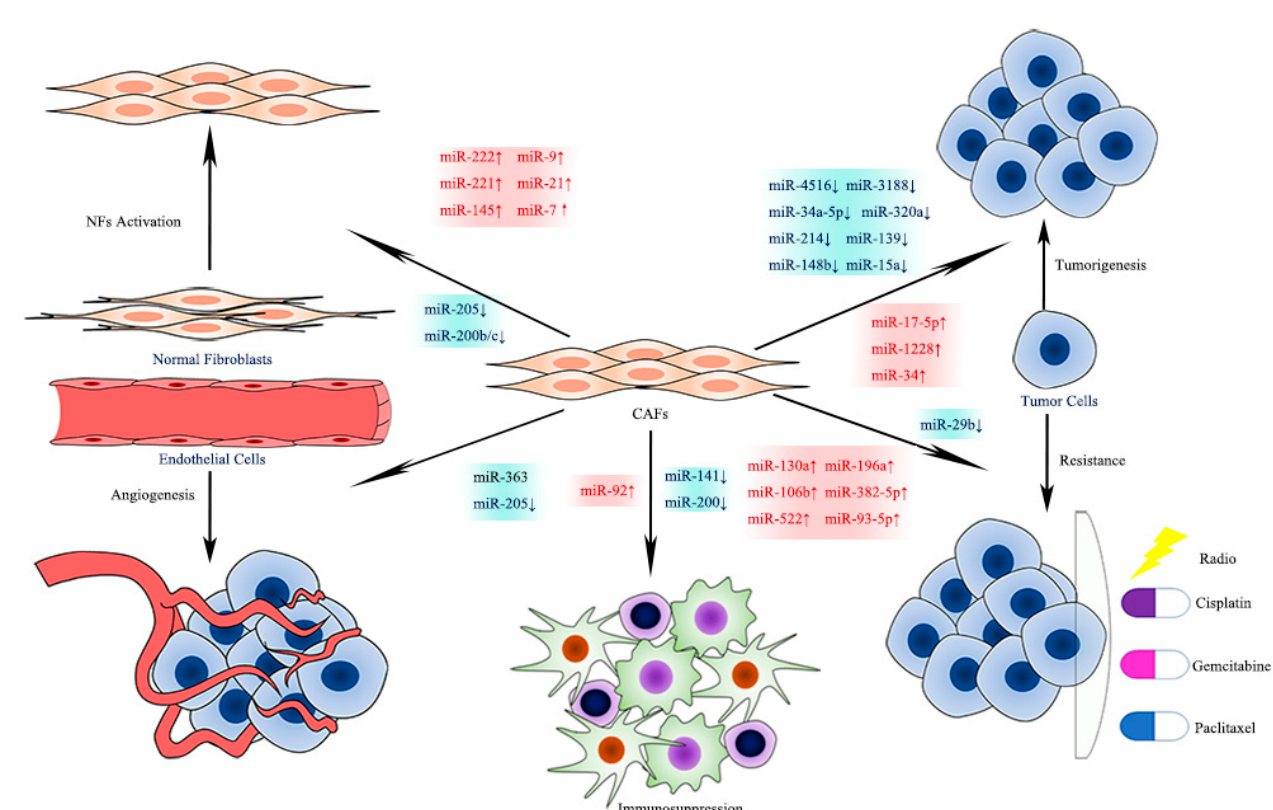
Figure 4. Effects of CAF-derived miRNAs on Tumor Biology.